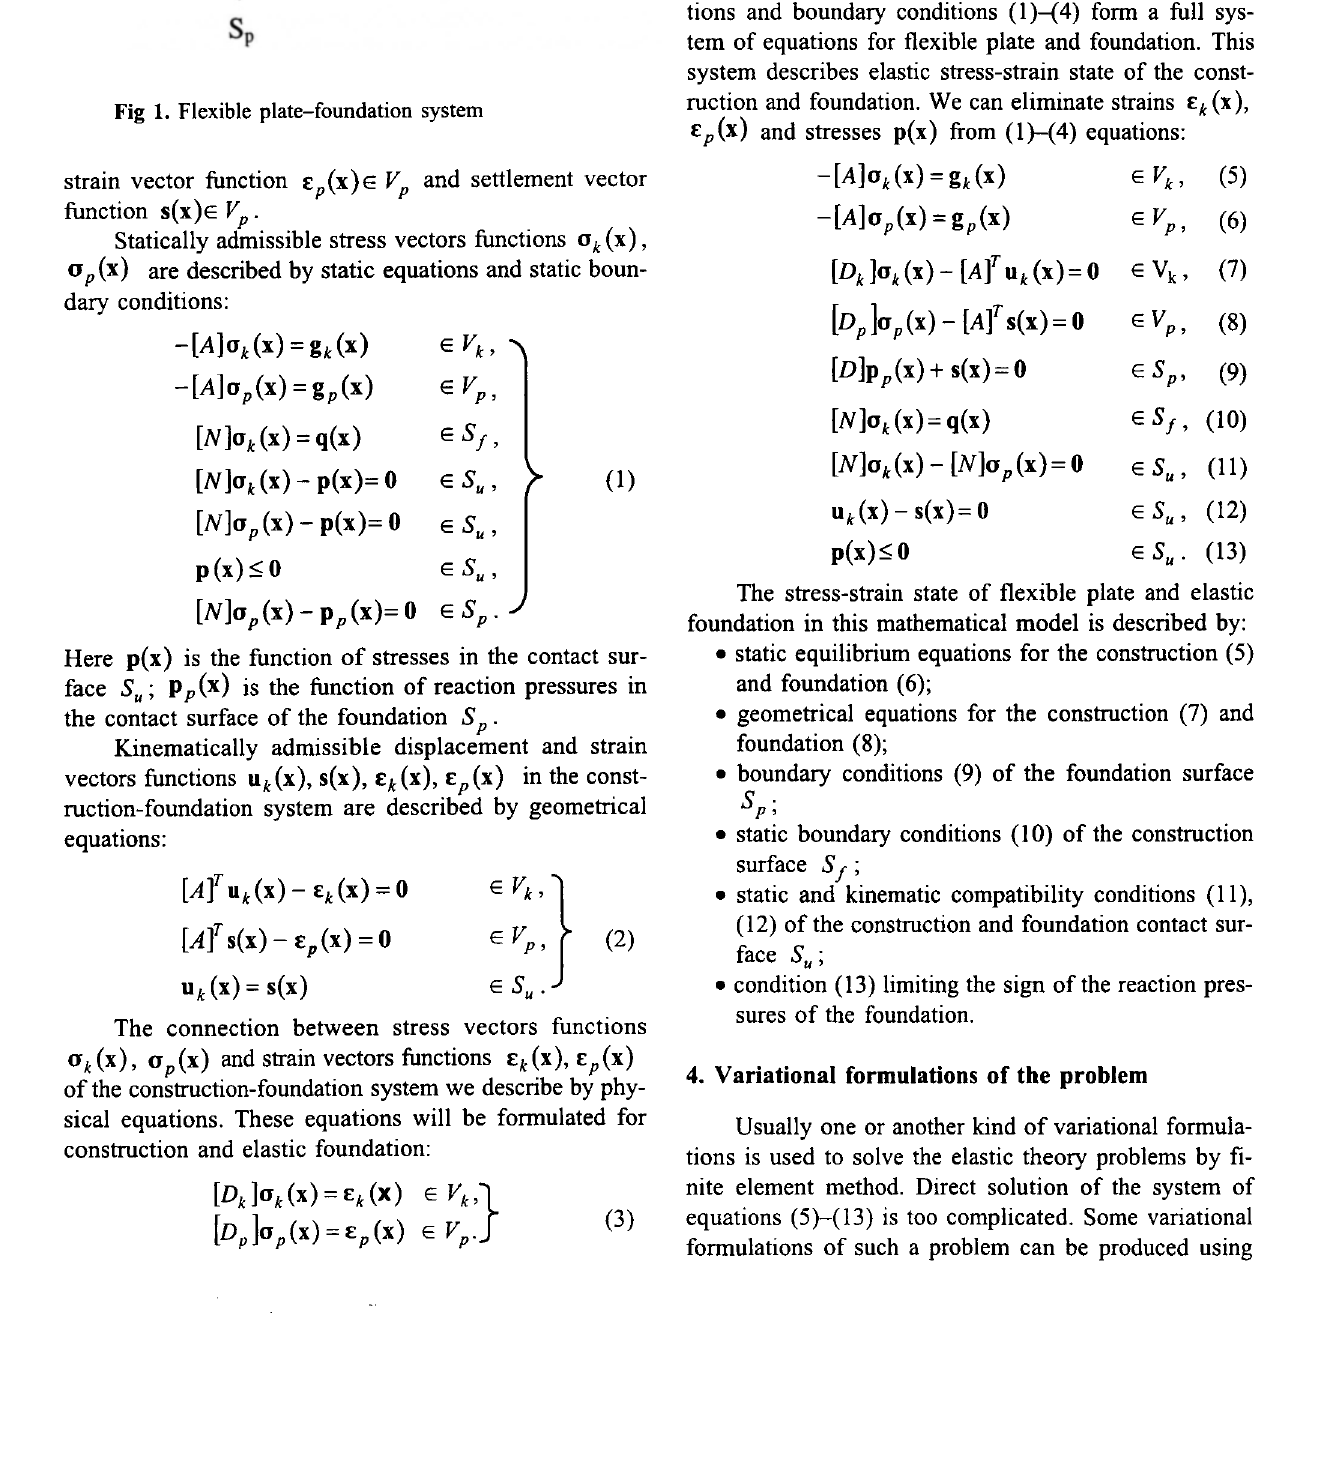
Fig 1. Flexible plate-foundation system strain vector function tp(x)E VP and settlement vector function s(x)E